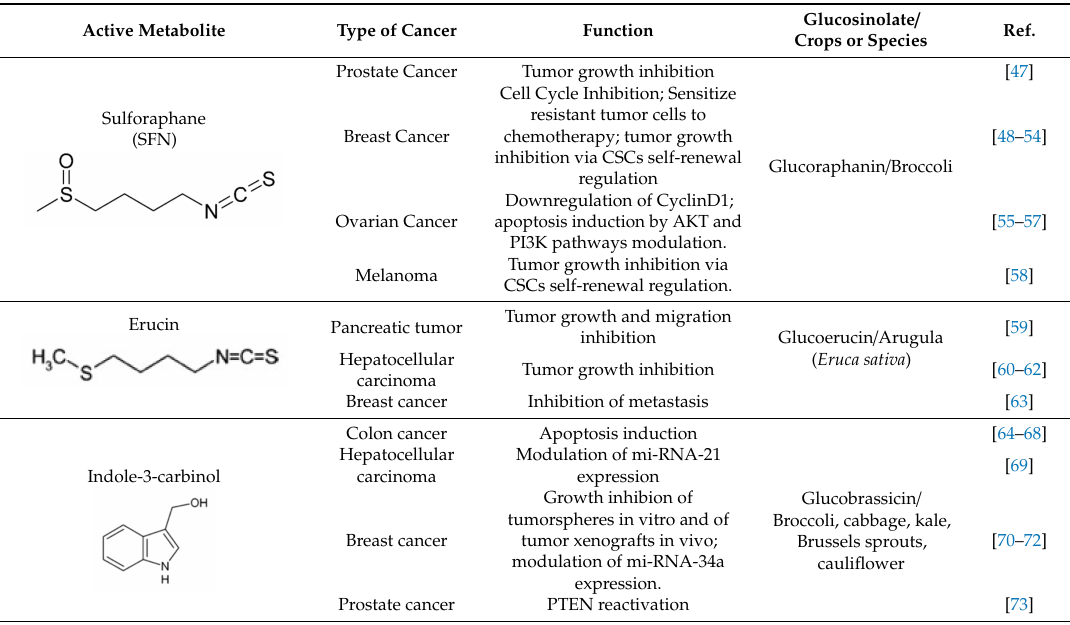
Table 1. Active metabolites from glucosinolates and their roles in more frequent cancer types (AKT, protein kinase B; PTEN, phosphatase and tensin